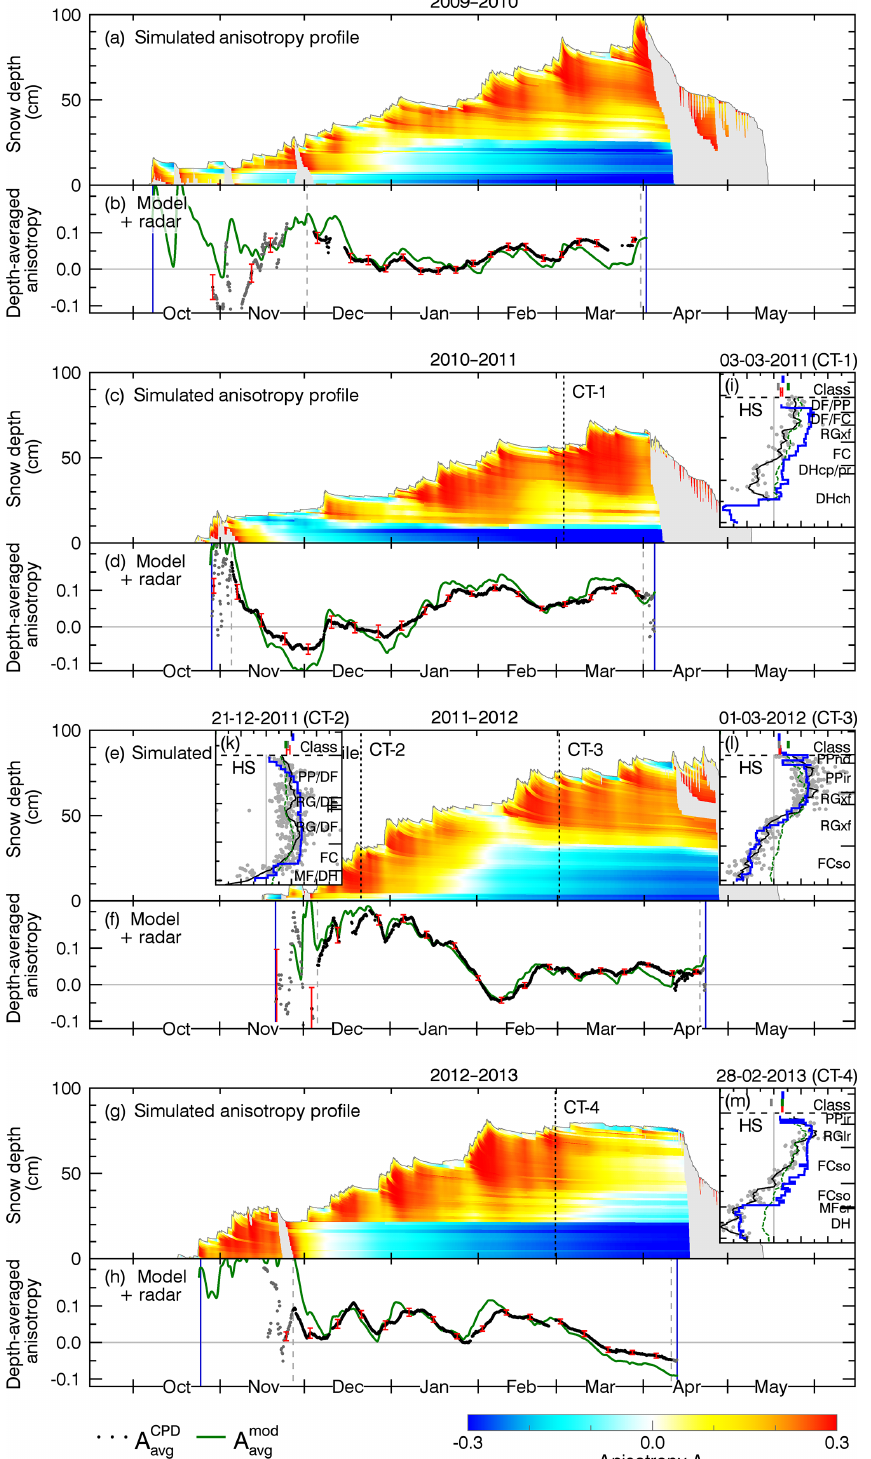
Figure A3. Modeled solution of all four seasons when the parameter α 2 is optimized for every season (row 1–4, Table 4).